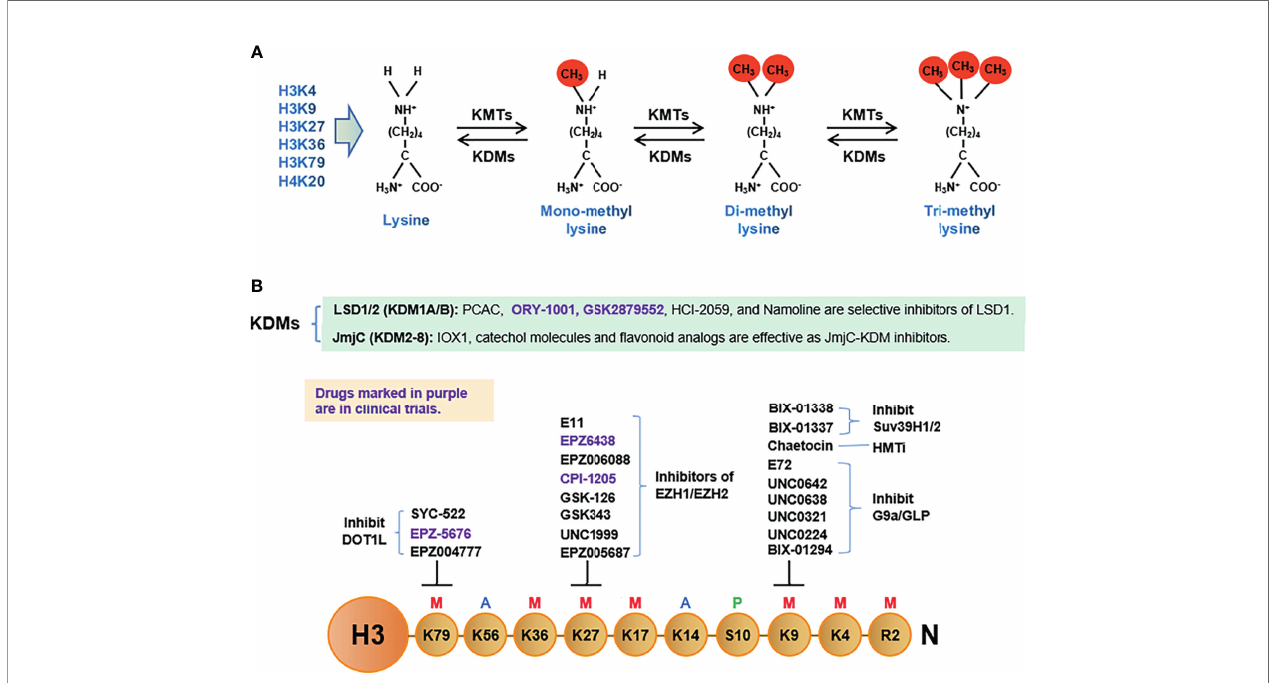
FIGURE 2 | The histone methylation process, inhibitors of histone lysine methyltransferases (HMTs) and histone lysine demethylases (KDMs). (A) . Schematic diagram of three states of lysine methylation: mono, di, and tri states. (B) . A summary of the histone methylation process and inhibitors of HMTs and